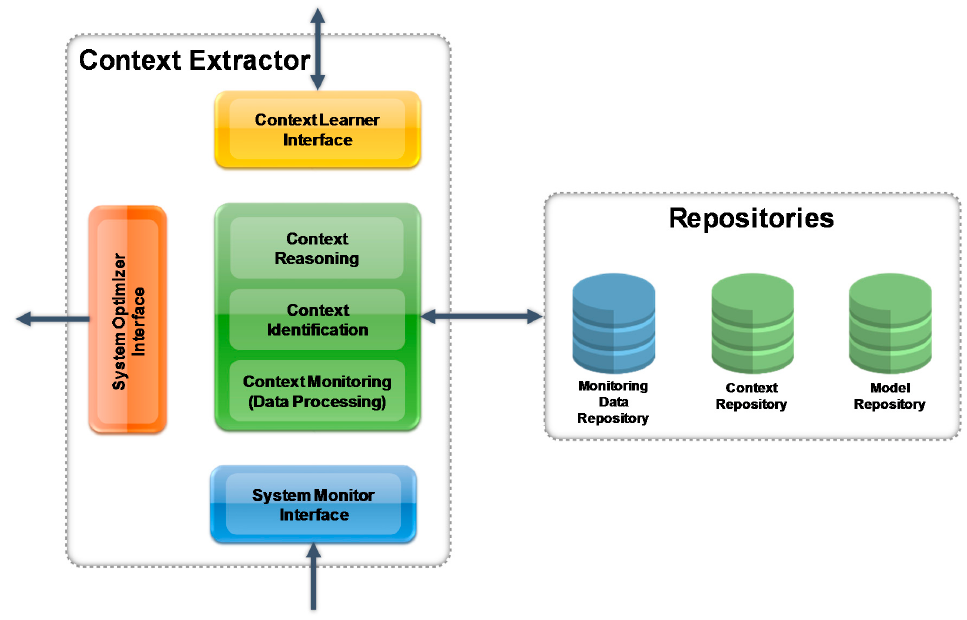
Figure 5. Context Extractor.